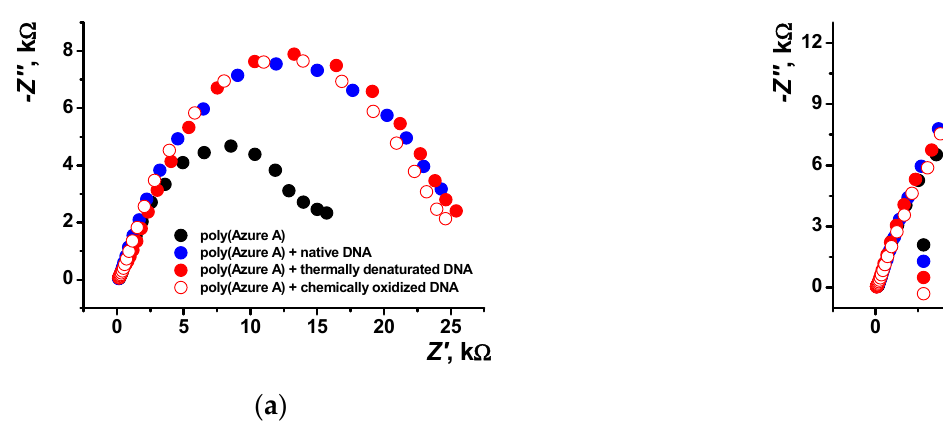
Figure 12. Equivalent circuit for the assessment of EIS parameters.